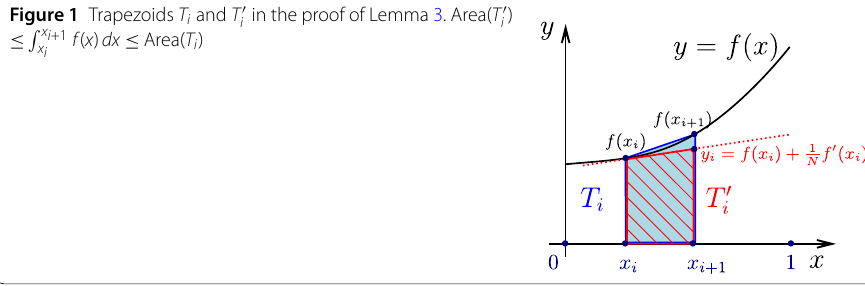
in the proof of Lemma 3. Area( T (cid:7) i